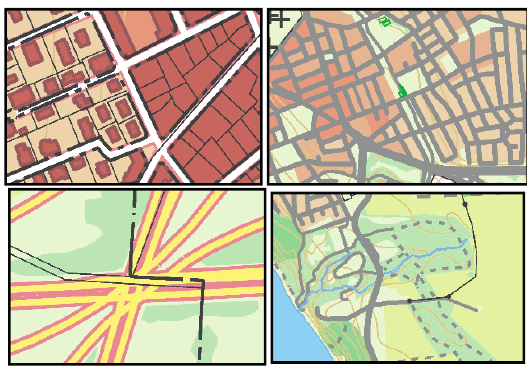
Figure 6. The two maps on the top are perceived as readable but are classified as non-readable; they both include a common geographic pattern. The two maps on the bottom are perceived as non-readable but are classified as readable; they both cover a more unusual geographic